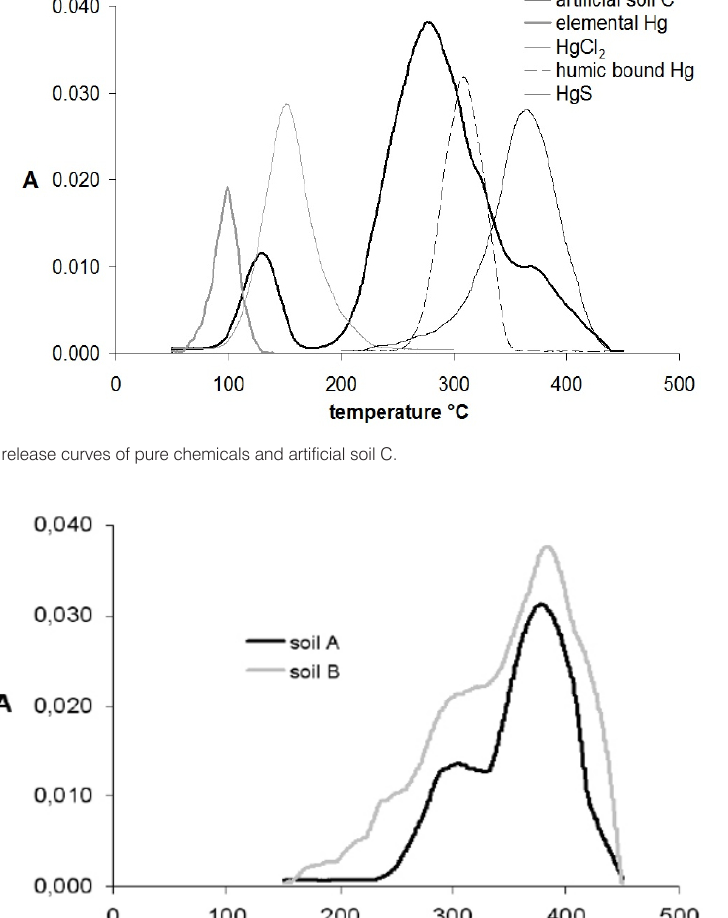
Fig. 4 (soil B) was 0.369 μg Hg in the mercury chloride form and 0.216 μg Hg in the form of mercury sulfide.